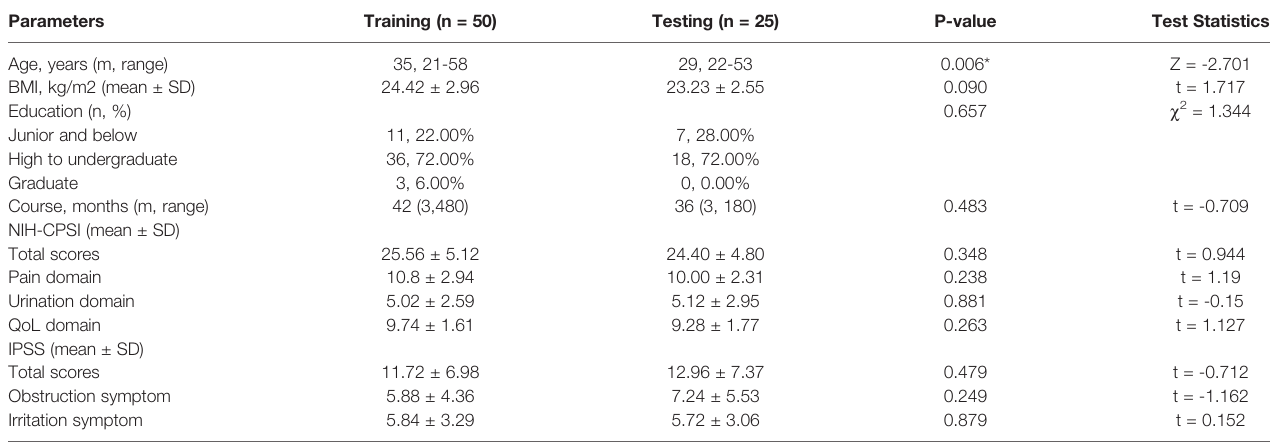
TABLE 1 | Baseline characteristics of the training and testing cohort.